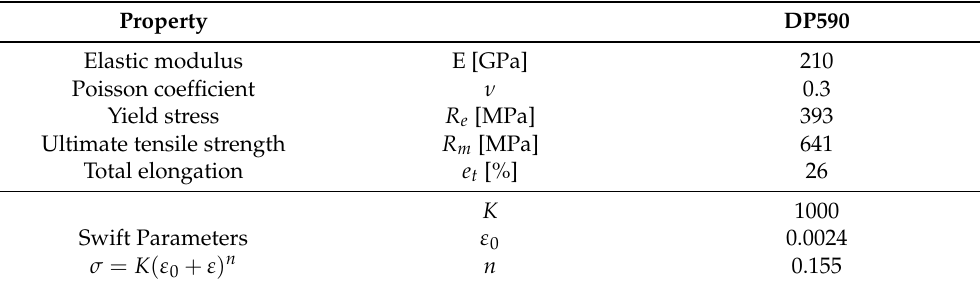
Table 3. Mechanical properties and Swift law hardening parameters of selected materials used in problem